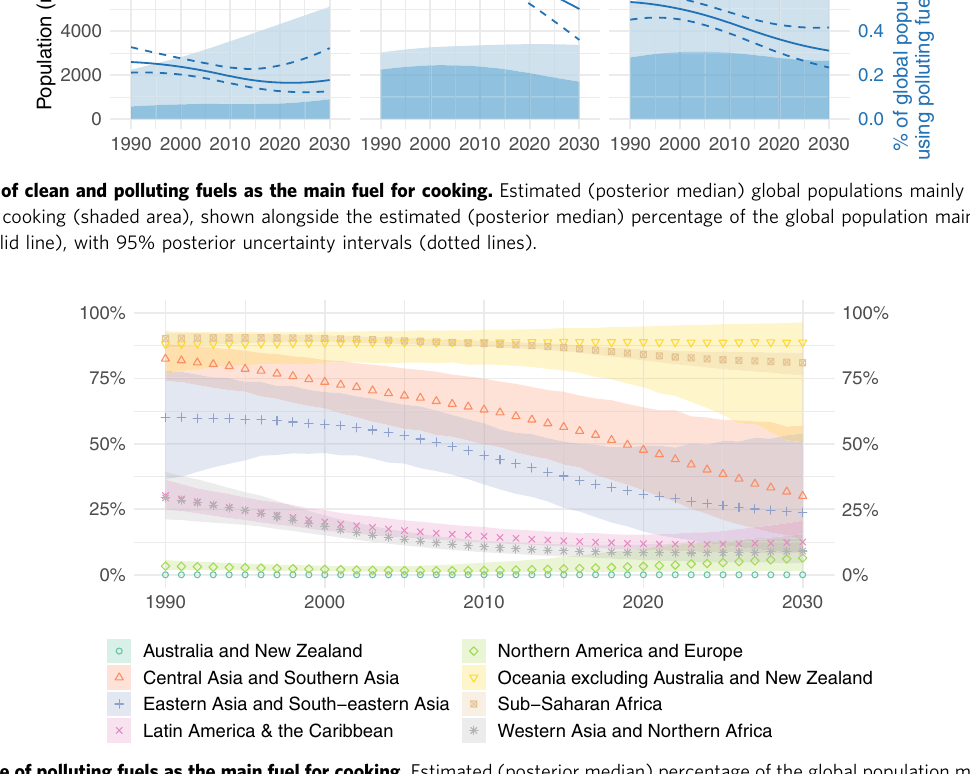
Fig. 3 Regional use of polluting fuels as the main fuel for cooking. Estimated (posterior median) percentage of the global population mainly cooking with polluting fuels in each SDG region, with 95% uncertainty intervals